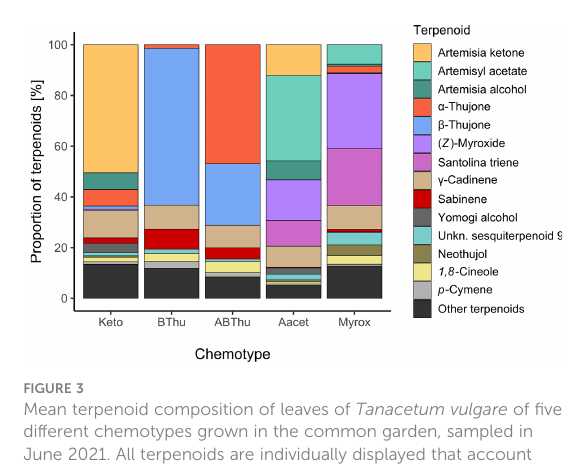
FIGURE 3 Mean terpenoid composition of leaves of Tanacetum vulgare of fi ve different chemotypes grown in the common garden, sampled in June 2021. All terpenoids are individually displayed that account together for ≥ 80% of the total chemotype composition; n = 55-60 individuals per